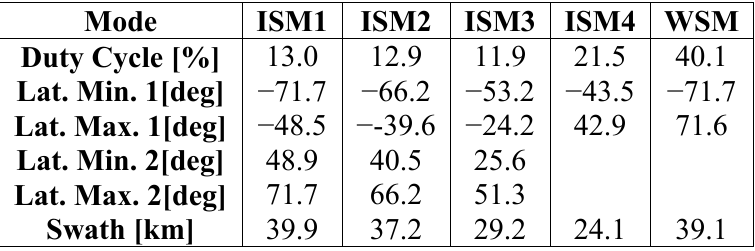
Table 3. Coverage statistics and duty cycle, assuming Envisat in different Swath Modes as illuminator. Minimum and maximum acquisition latitudes, and mean width of the bistatic swath (minimum is 10 km) are reported. Note that for ISM1, ISM2 and ISM3, two latitude belts are